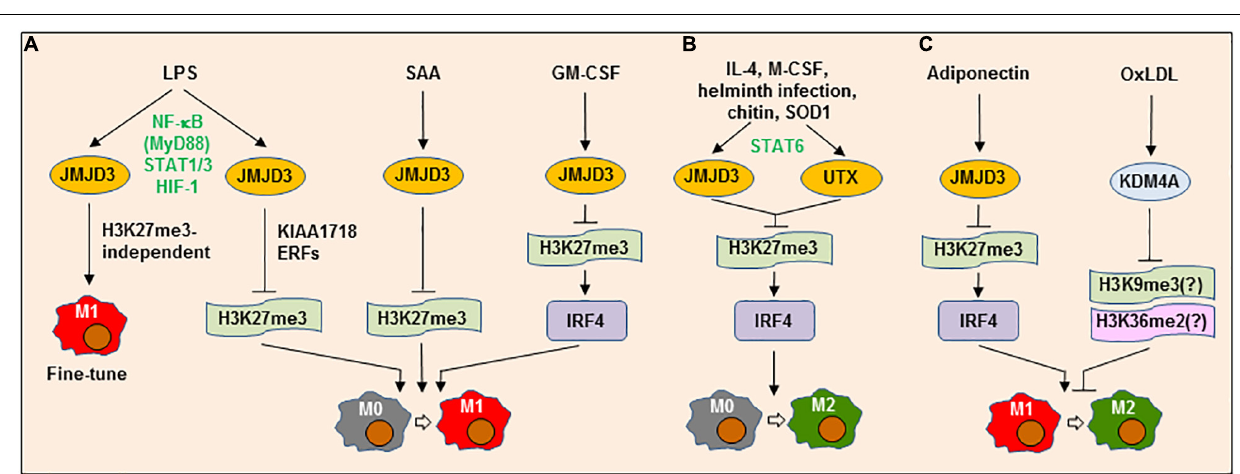
FIGURE 2 | Lysine demethylases can play dual roles in both M1 and M2 polarization or M1 → M2 repolarization. (A) LPS up-regulates the lysine demethylase (KDM) jumonji domain-containing (JMJD3) (KDM6B) via a process involving multiple transcription factors (e.g., NF- κ B/MyD88, STAT1/3, and HIF-1), which in turn acts to either fine-tune M1 phenotype via an H3K27me3-independent process or promote M1 polarization, which requires another KDM KIAA1718 and elongation-regulatory factors (ERFs). Similarly, JMJD3 is involved in M1-like polarization induced by serum amyloid A (SAA) or